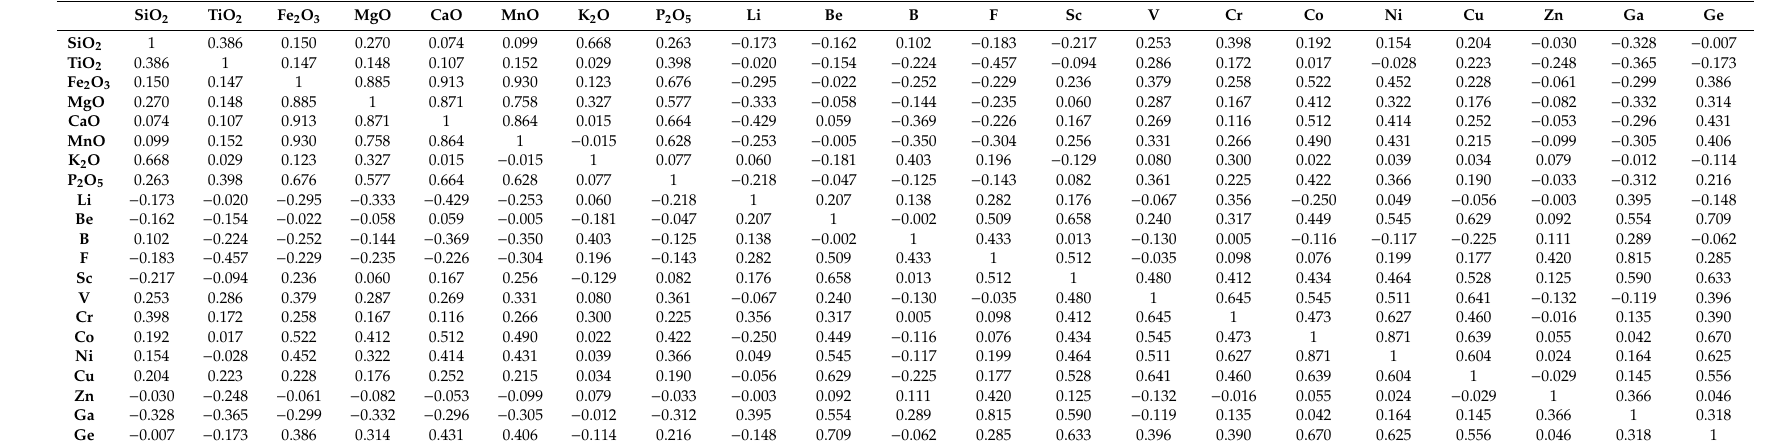
Table 2. Correlation using the improved alr approach on coal and ash basis (Datanhao mine).